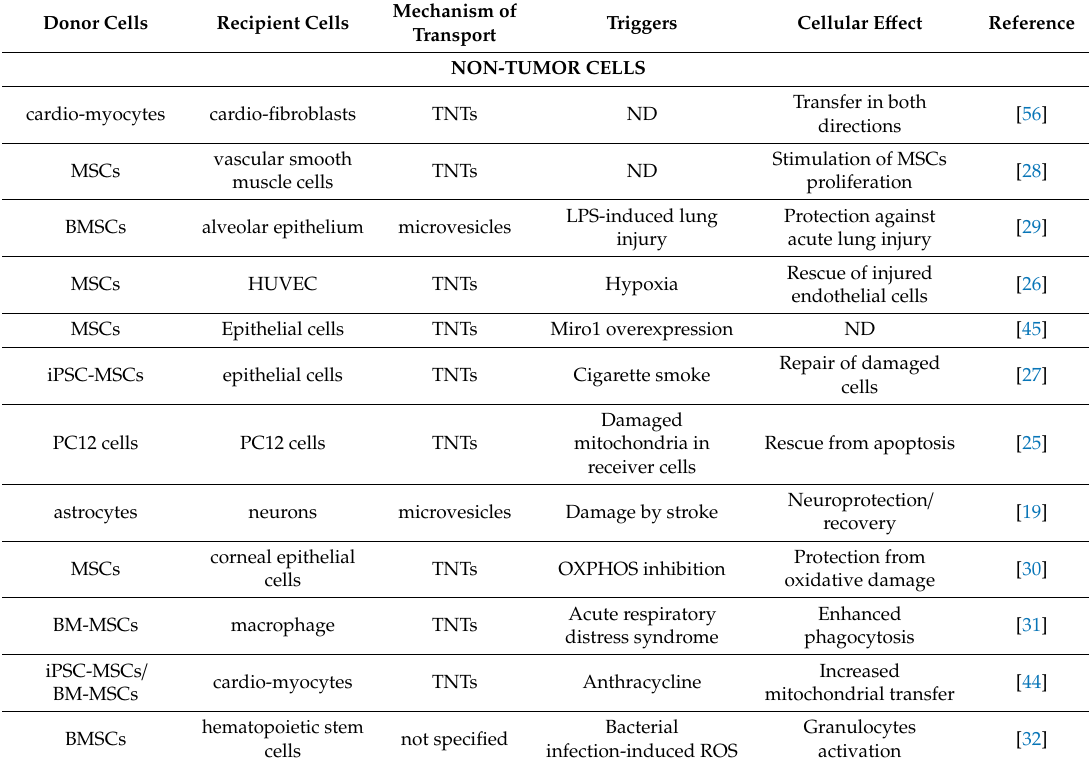
Table 1. Mitochondrial transfer